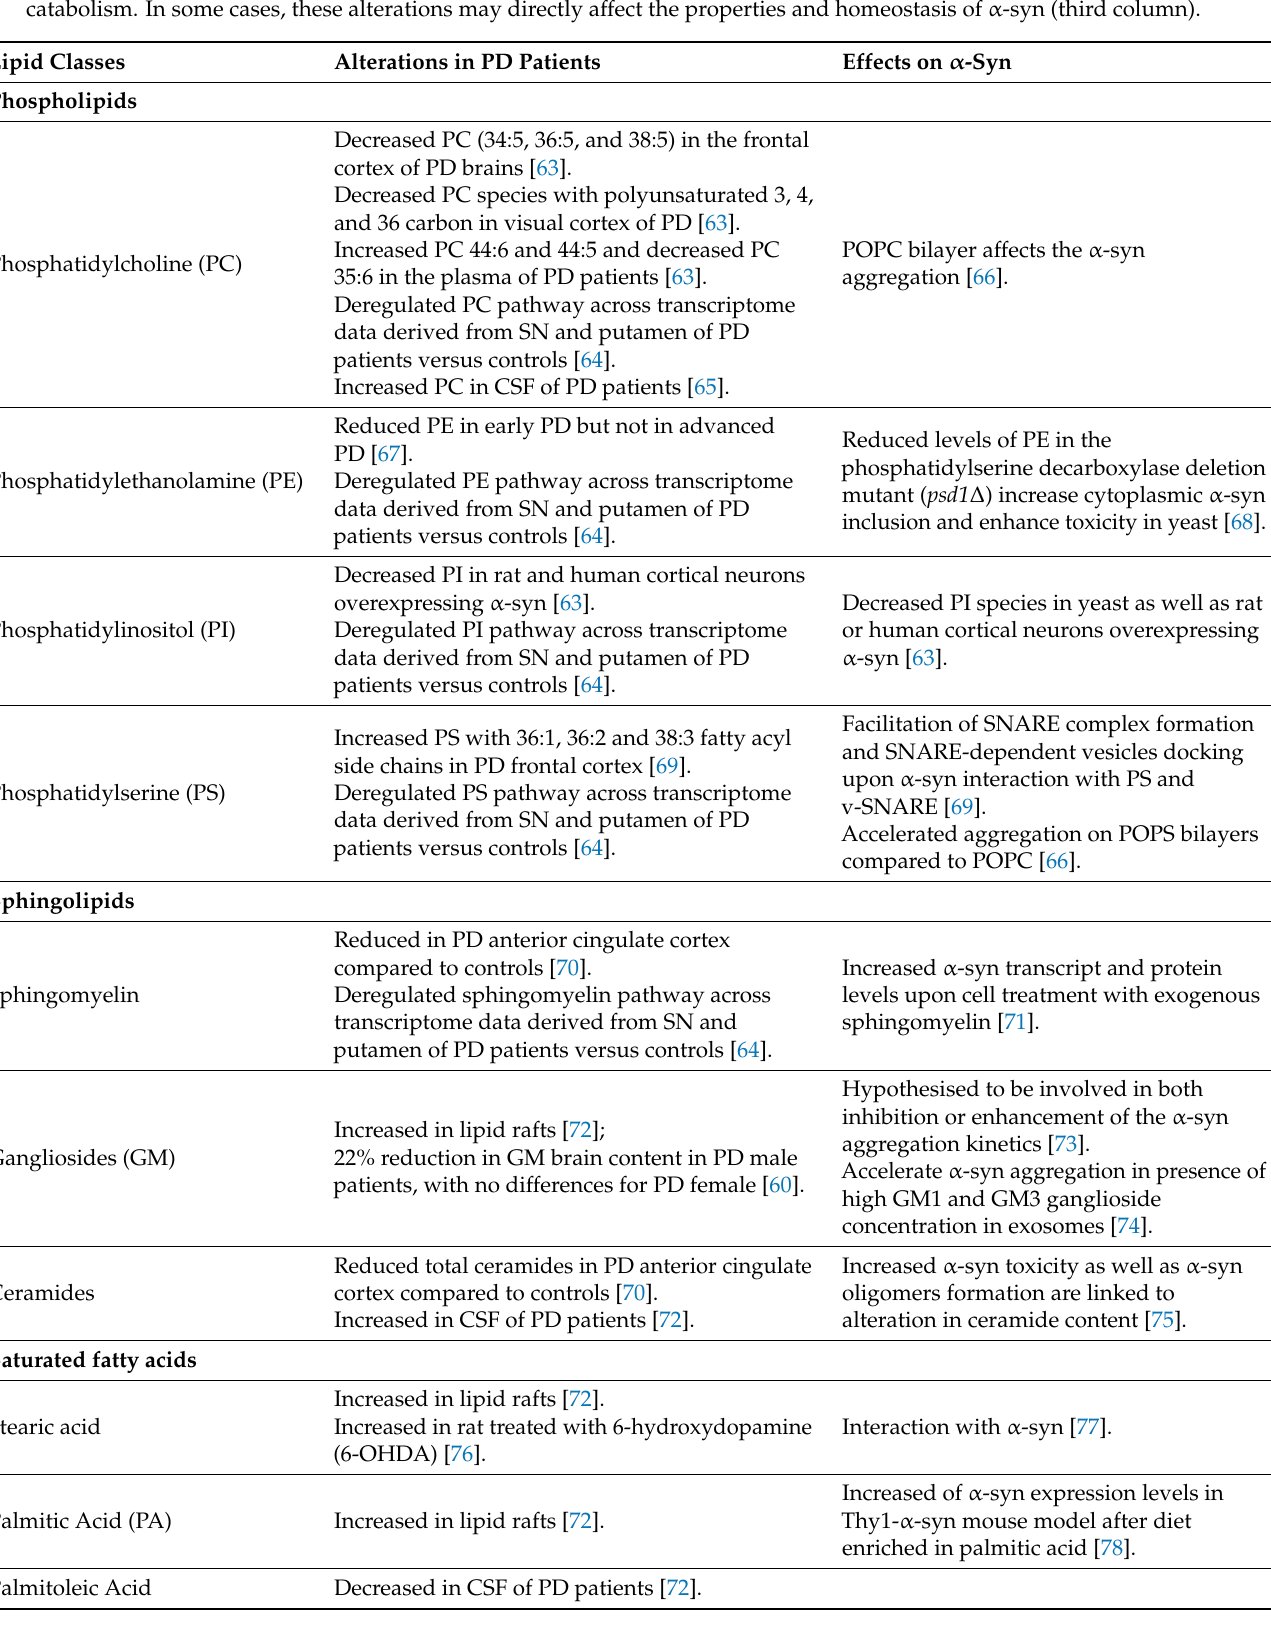
Table 2. Overview of the main lipid classes altered in PD patients and models and their effect on α -synuclein ( α -syn). This table provides some examples of different classes of lipids (first column) whose levels are altered in samples and biofluids from PD patients compared to controls (second column). We have also reported examples of enzymes associated with lipid metabolism whose activity is deregulated in PD as well as examples of genetic risk factors for PD associated with lipid catabolism. In some cases, these alterations may directly affect the properties and homeostasis of α -syn (third